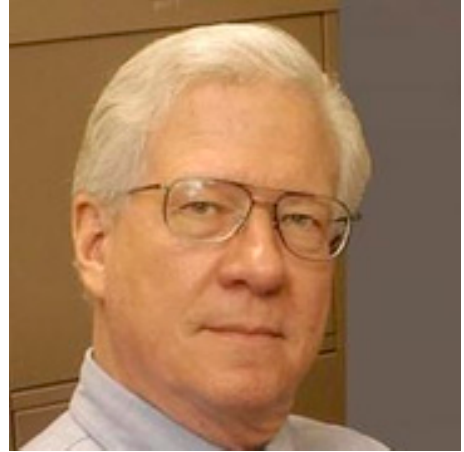
Figure 1. Professor Emeritus Calvin H. Bartholomew.